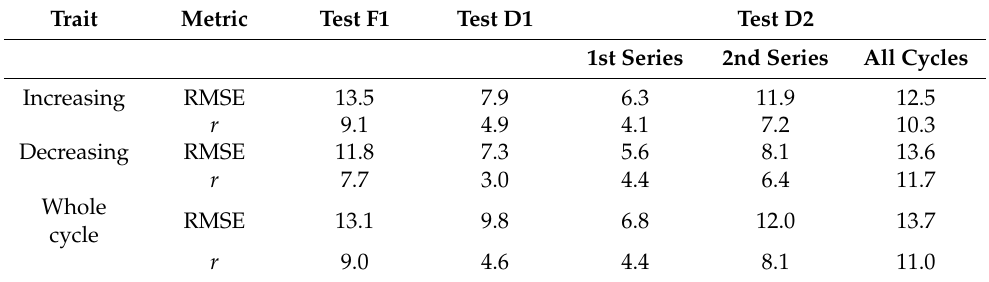
Table 3. Comparison of results obtained for the three tests by applying the proposed temperature compensation approach based on dummy sensor resistance R d . Calibration is with respect to displacement. Values are expressed as a percentage of the